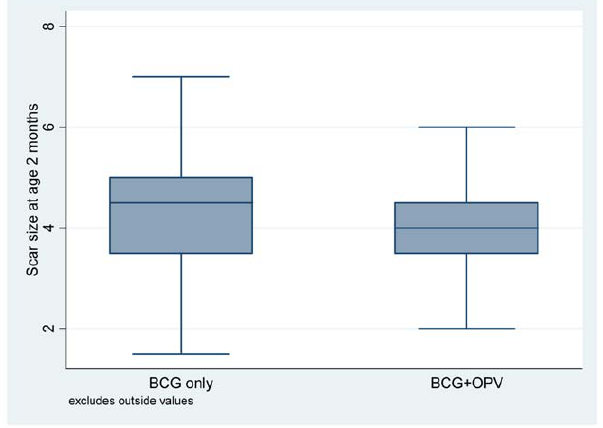
Figure 4. Comparison of BCG scar size at age 2 months between infants who got or did not get OPV with BCG at